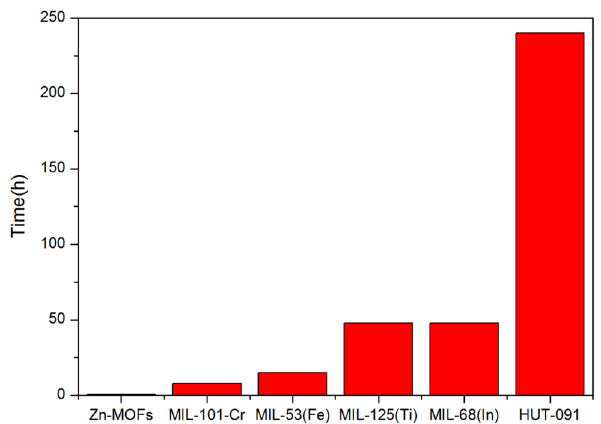
Figure 1: Comparison of the preparation time of